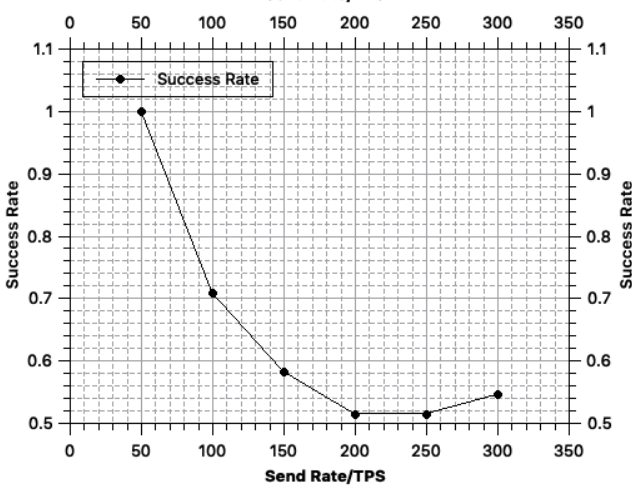
Figure 4. Transaction success